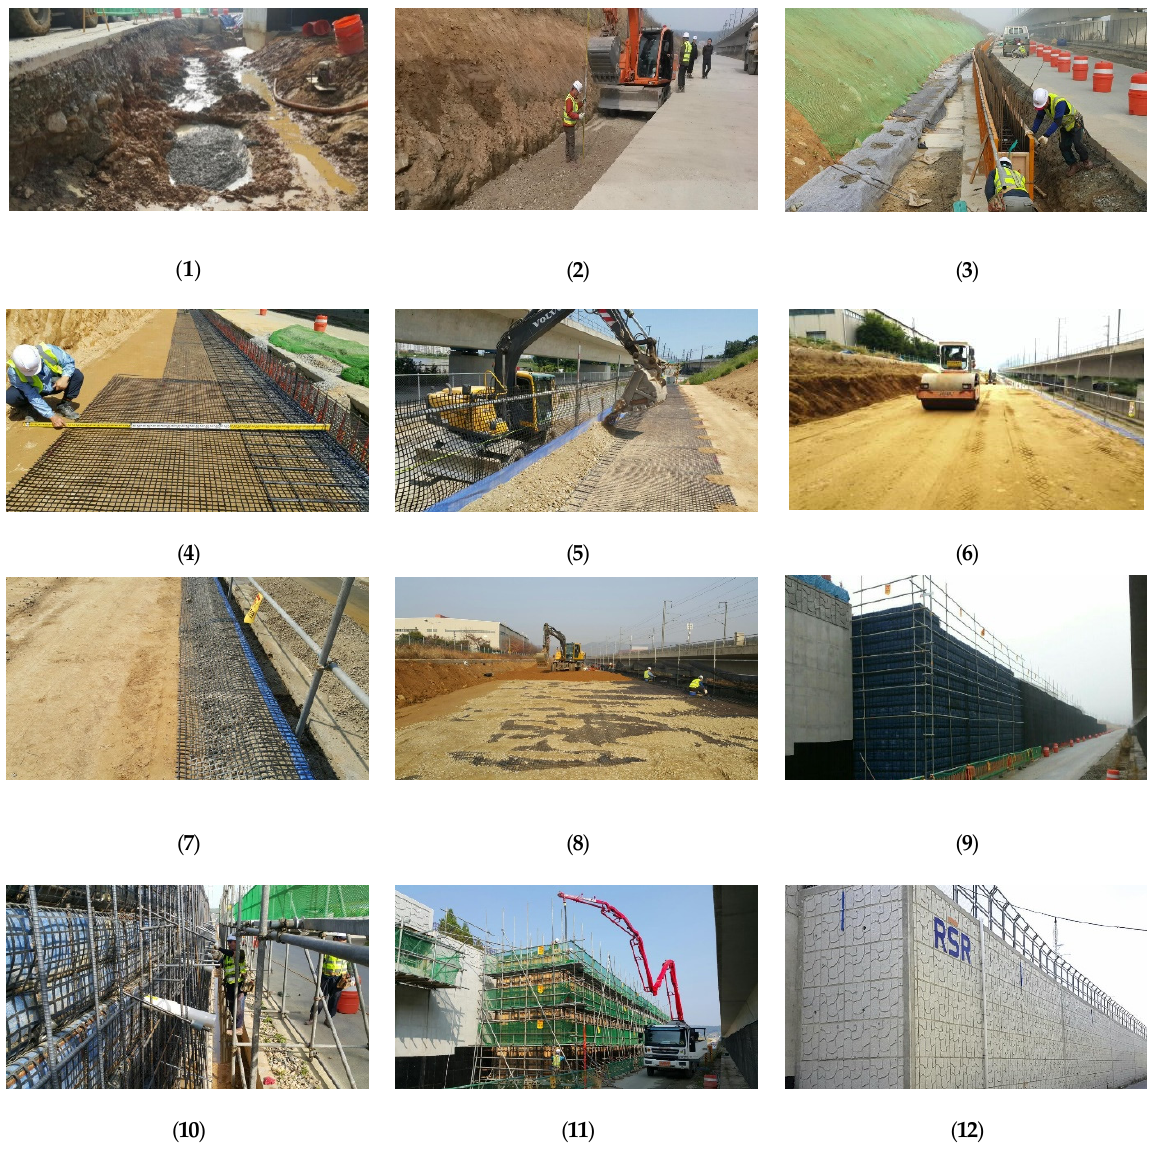
Figure 3. RSR construction process. ( 1 ) Installation of cast-in-place concrete pile; ( 2 ) bench cut, spreading, and compaction processes of 3% cement-treated gravel; ( 3 ) installation of small strip foundation; ( 4 ) installation of geogrids and nets of welded rebars; ( 5 ) laying of 3% cement-treated gravel; ( 6 ) compaction; ( 7 ) rolling up the geogrid; ( 8 ) repetition of steps ( 4 ) to ( 7 ) to obtain the 17th layer; ( 9 ) stabilization of the embankment; ( 10 ) installation of rebars and connectors; ( 11 ) installation of forms and placing of concrete for rigid wall; ( 12 ) curing and completion of RSR.